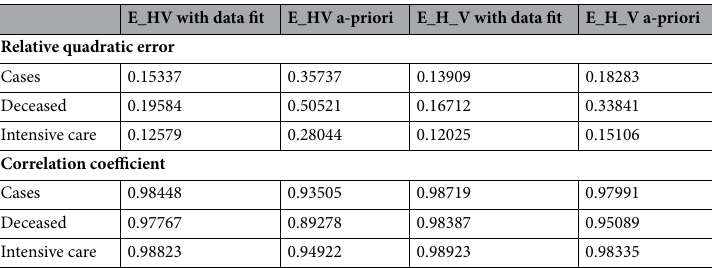
Table 4. Relative average quadratic error and correlation coefficients for E_HV and E_H_V models, for both the versions with data fitting and with a-priori coefficients.